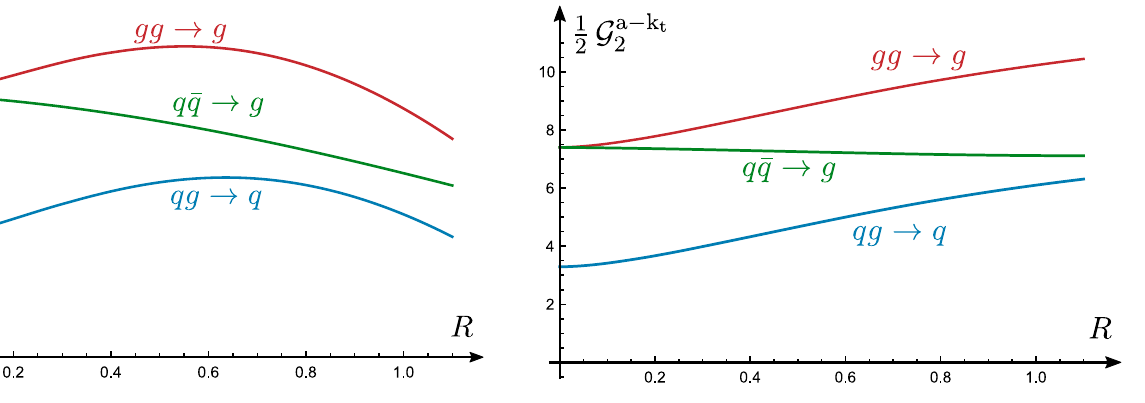
Fig. 4 Two-loops NGLs coefficient as a function of jet radius for C–A and k t clustering